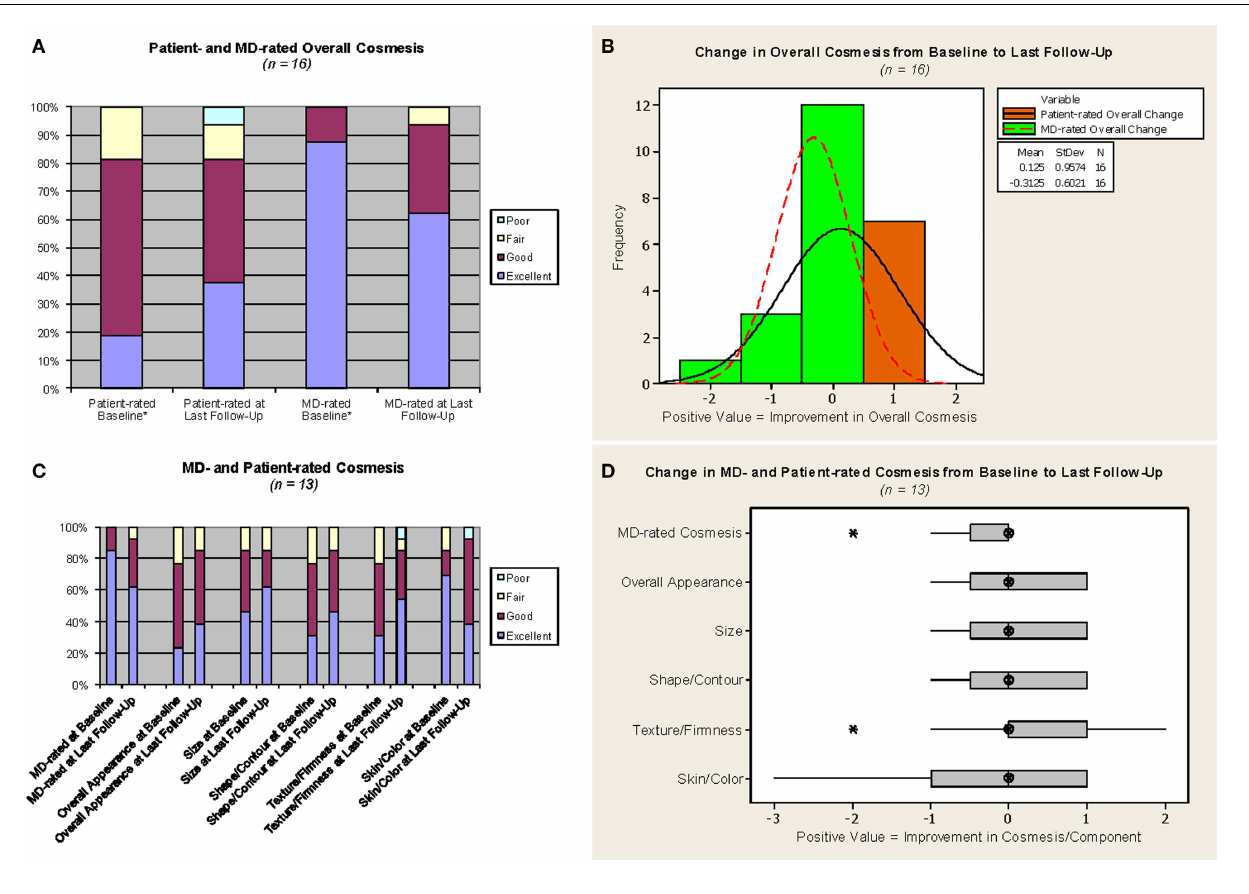
from APBI completion for (C,D) was 23.4months. (A,C) Light blue = poor, yellow = fair, maroon = good, purple = excellent. (B) Orange with solid line = patient-rated overall change, green with dotted line = MD-rated overall change. (D) Hatched circle = median, shaded box = interquartile range, asterisk = outlier (more than 1.5 x interquartile range below the first quartile or above the third quartile).